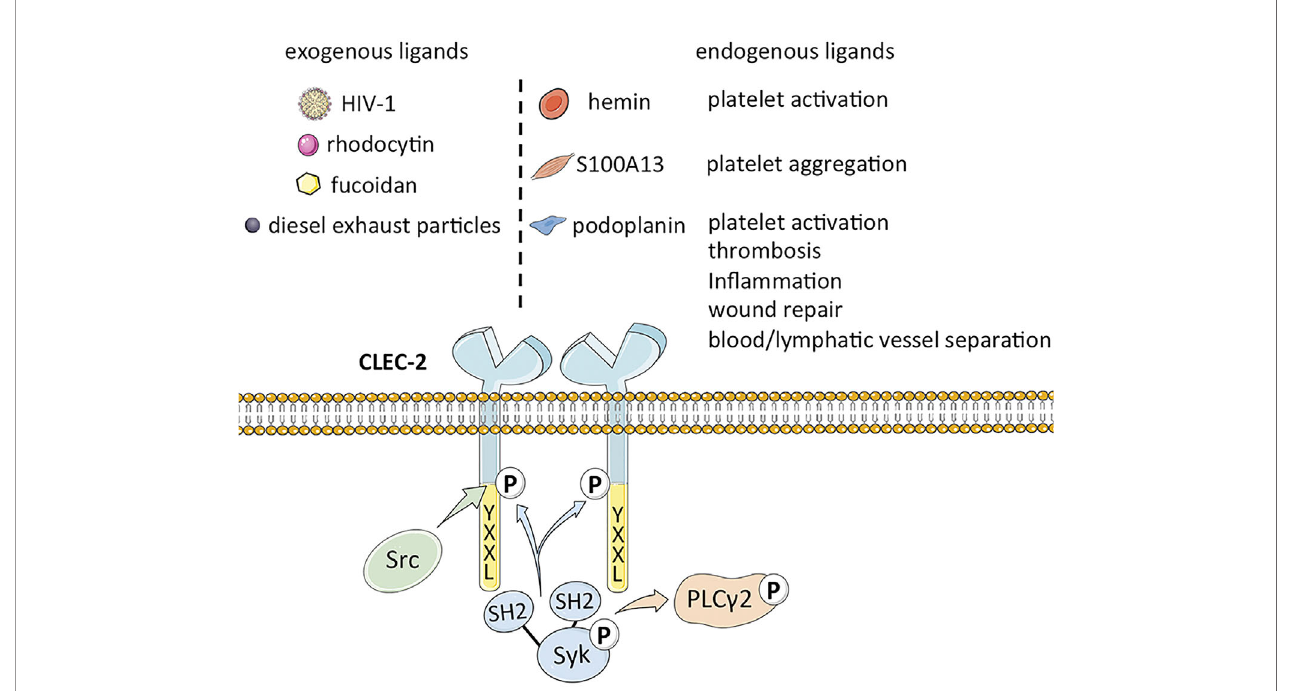
FIGURE 1 | The structure of CLEC-2 and the function of its endogenous